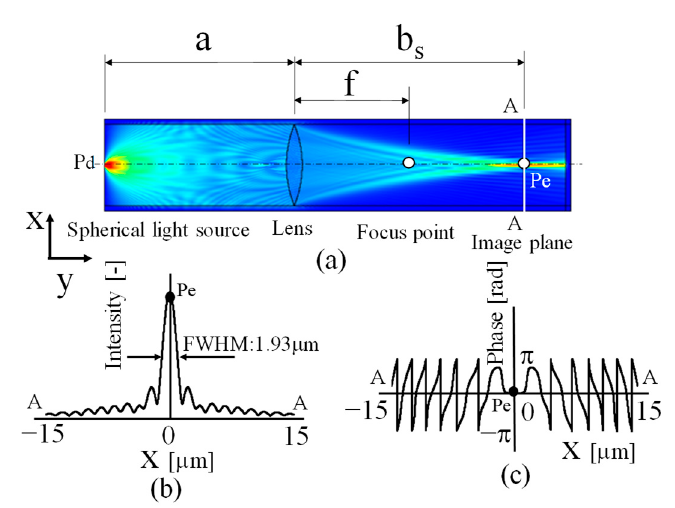
Figure 4. Optical system check when a light source is set on the light axis. ( a ) Electromagnetic field simulation result. ( b ) Intensity distribution in section A-A. ( c ) Phase distribution in section A-A.